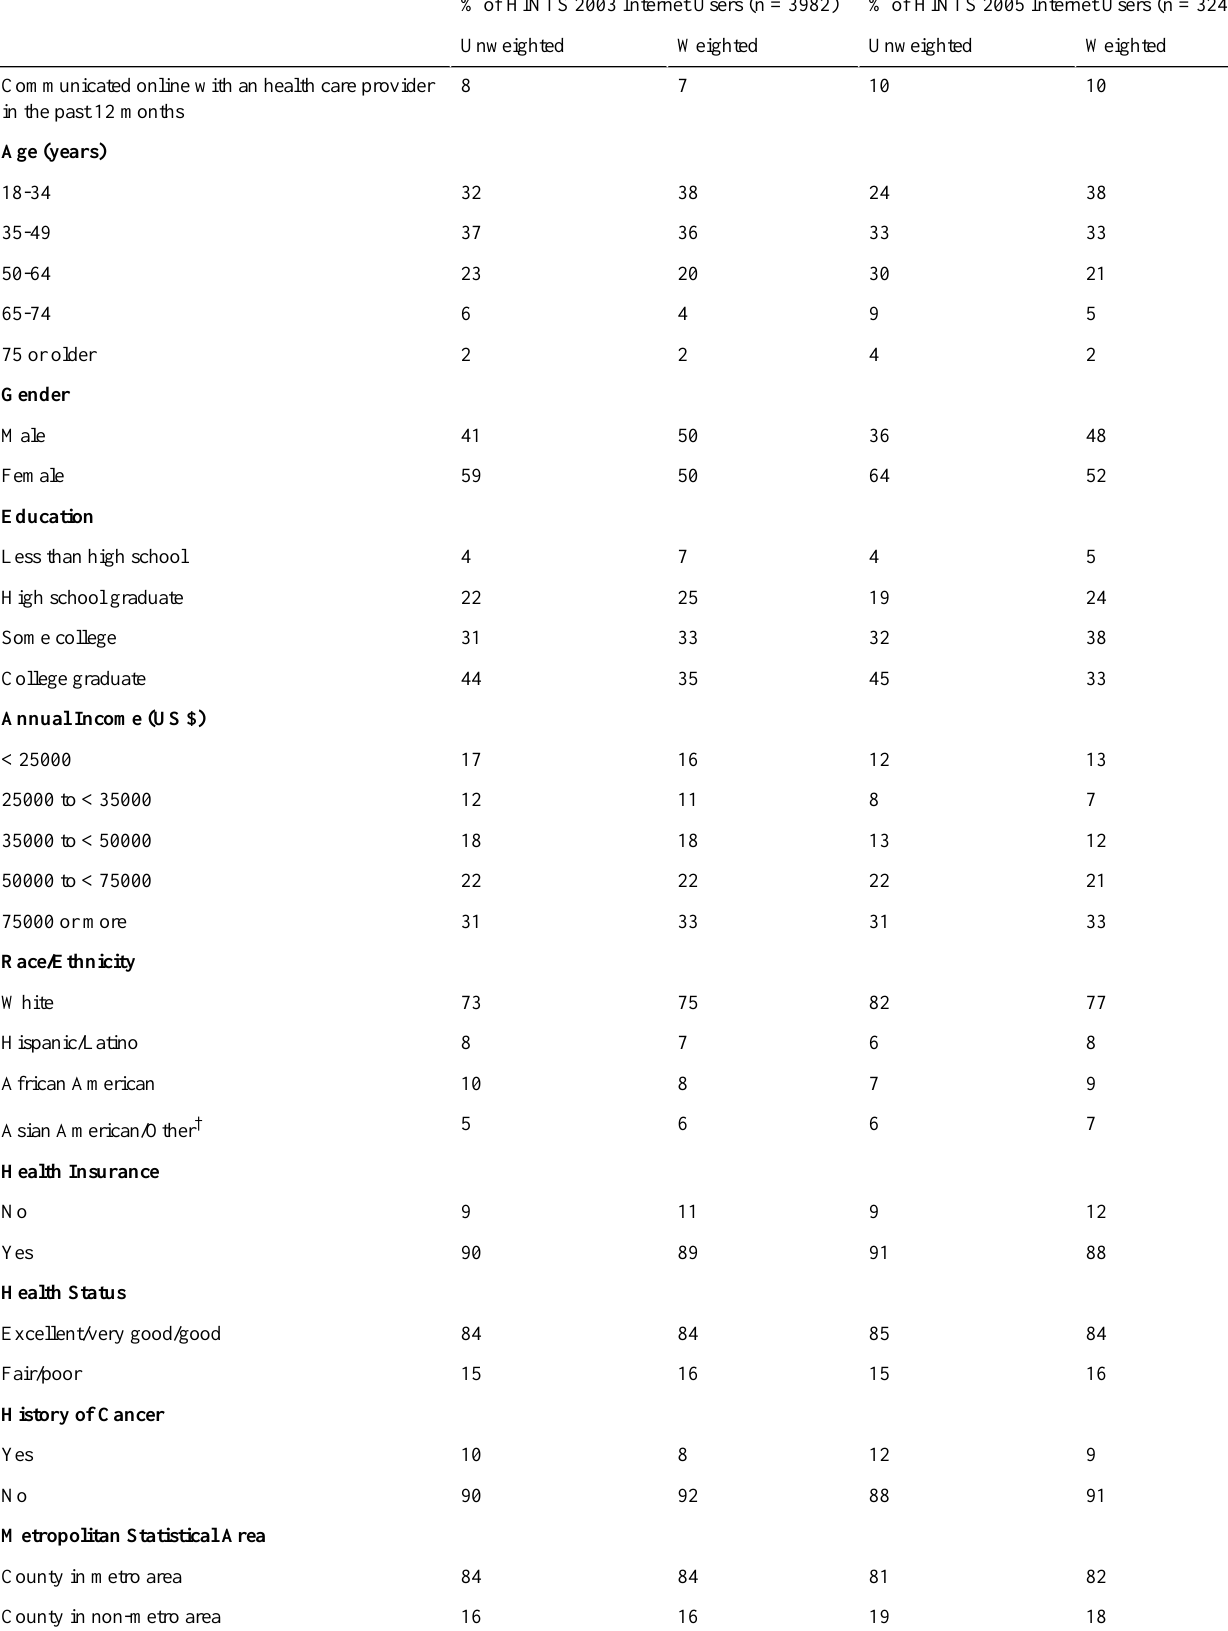
Table 1. Sample characteristics of Internet users in HINTS 2003 and HINTS 2005